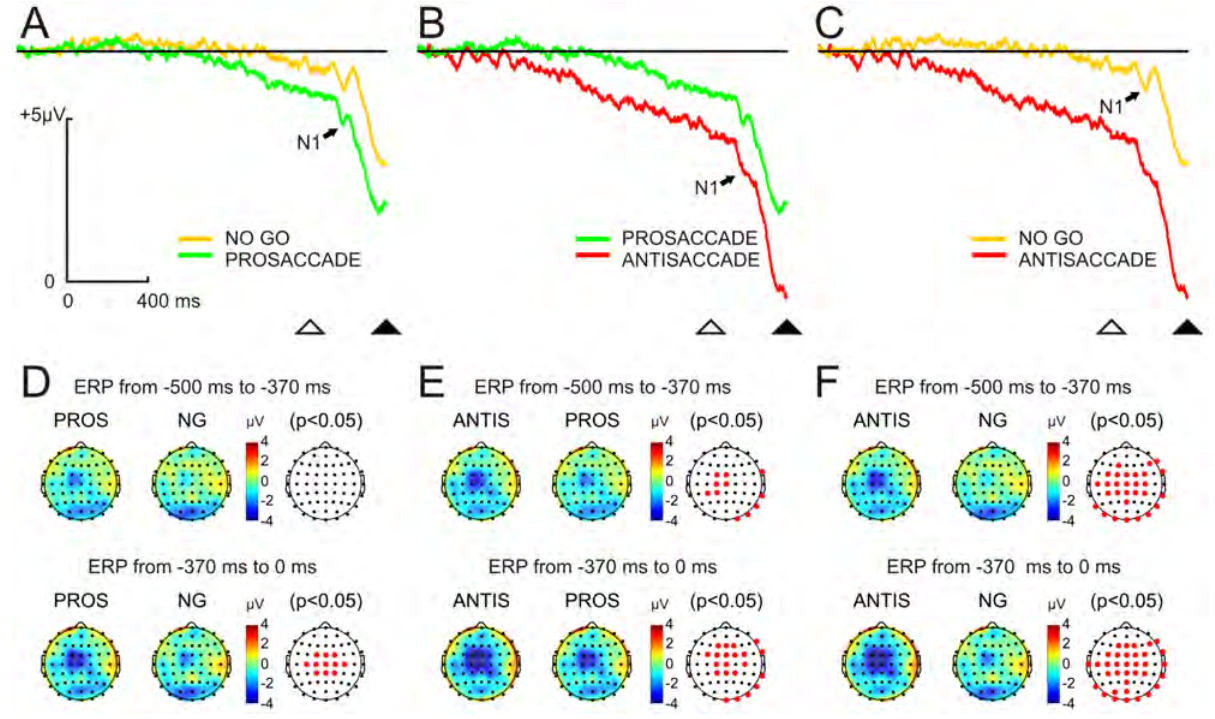
Figure 3. Event-related potentials (ERP) and statistical comparison of scalp maps during the preparatory period. From A–C, ERP comparison between each pair of tasks at the electrode FCz during the preparatory period. Color traces indicate the ERP for each type of task (red for antisaccade, green for prosaccade and yellow for no-go). During the instructive period (while S1 was present), a progressive negative potential was developing. During the gap period, this negative potential increased abruptly. The black horizontal line denotes the baseline value. This negativity was greater during prosaccadic than no-go (A), during antisaccadic than prosaccadic (B) and during antisaccadic than no-go (C) tasks. The offset of S1 (open triangle) and the onset of S2 (filled triangle) are indicated. Please note the visual evoked potentials (N1) triggered by the offset of S1 (black arrows). Calibration and voltage polarity for A–C is indicated in A. D–F show in the first two columns the topographical voltage distribution and in the third the statistical comparison between the same pairs of tasks shown in A–C, during the last 500 ms of the instructive (top row) and gap (bottom row) periods. Scalp distribution of voltage negativity was mainly located fronto-centrally. During the instructive period, significant differences in negativity were exclusively found between antisaccadic versus prosaccadic and no-go tasks. During the gap period, significant differences were found between the three tasks. Red points indicate electrodes with statistical differences (p , 0.05).